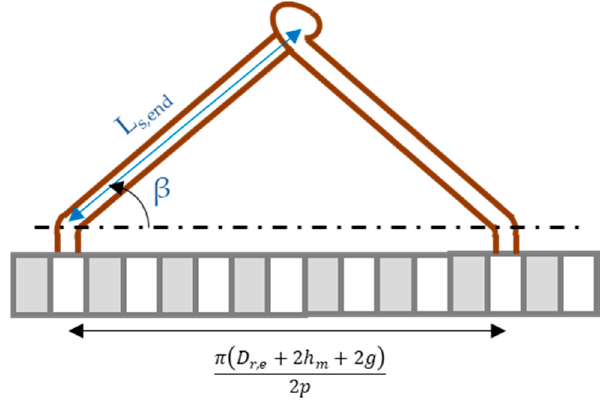
Figure 3. Linearized machine and end windings.